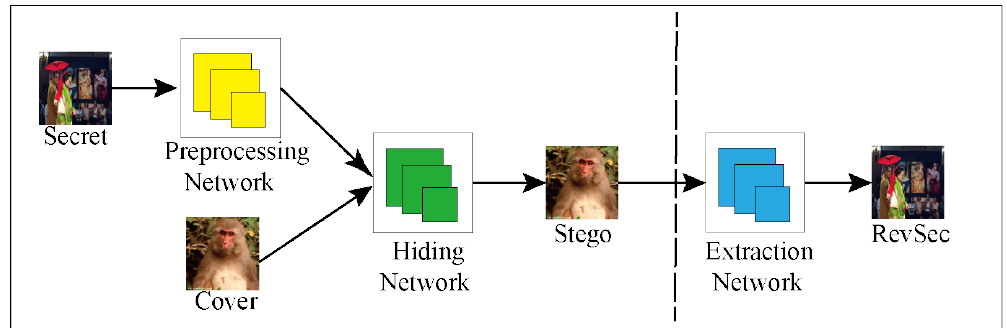
Figure 3. Image steganography architecture.